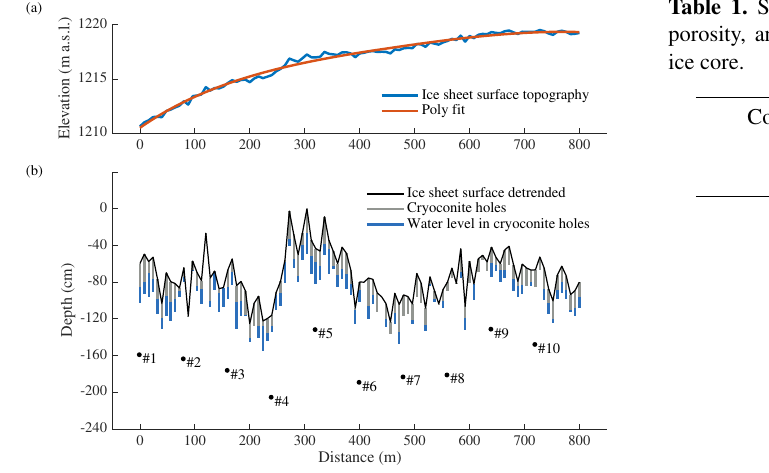
Figure 7. (a) Ice sheet surface topography along the 800m study transect extracted from a 6cm resolution stereo-photogrammetric digital elevation model derived from RGB imagery collected 10 July 2016 from a quadcopter drone and the second-order poly- nomial best fit. (b) Ice sheet surface topography detrended with the polynomial best fit, cryoconite hole depths (vertical grey bars), and cryoconite hole water levels (vertical blue bars) sampled along the 800m study transect, adjusted to a common vertical reference. Lo- cations of the 10 shallow boreholes and their depth relative to the detrended surface are labelled #1–10.